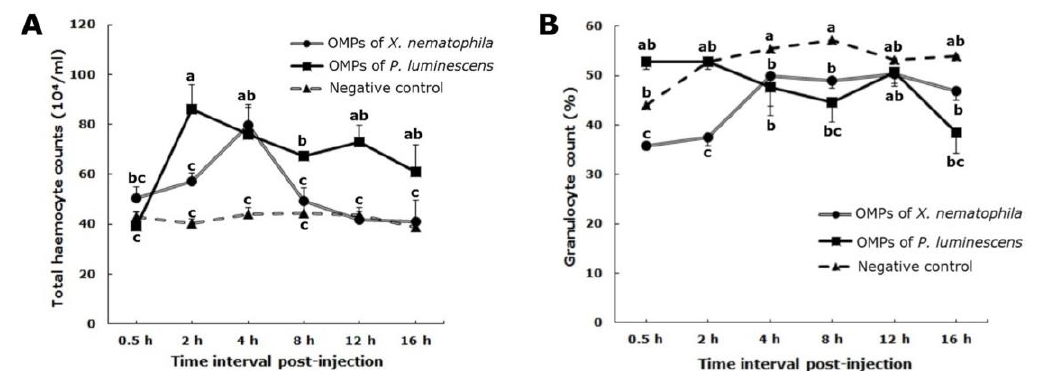
Figure 2. Changes in the patterns of cellular defense elements in fifth instar larvae of Spodoptera exigua after injection with outer membrane proteins of either Xenorhabdus nematophila or Photorhabdus luminescens , ( A ) total haemocyte count, ( B ) granulocyte percentage. Each measurement consists of eight replications. The vertical bars represent the standard error of the means. Different letters above the error bars indicate a significant difference of interactive effect means between outer membrane proteins from the two bacterial species × interval times at α = 0.05 (Slicing test).